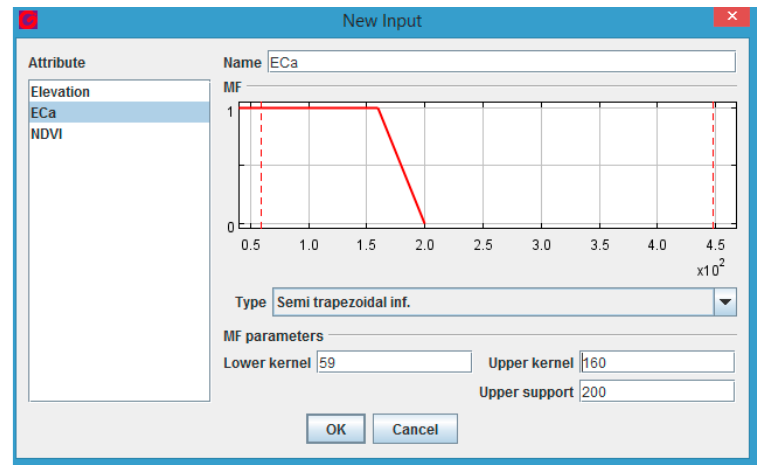
Figure 10. Implementation of the risk function associated with the EC a information layer.